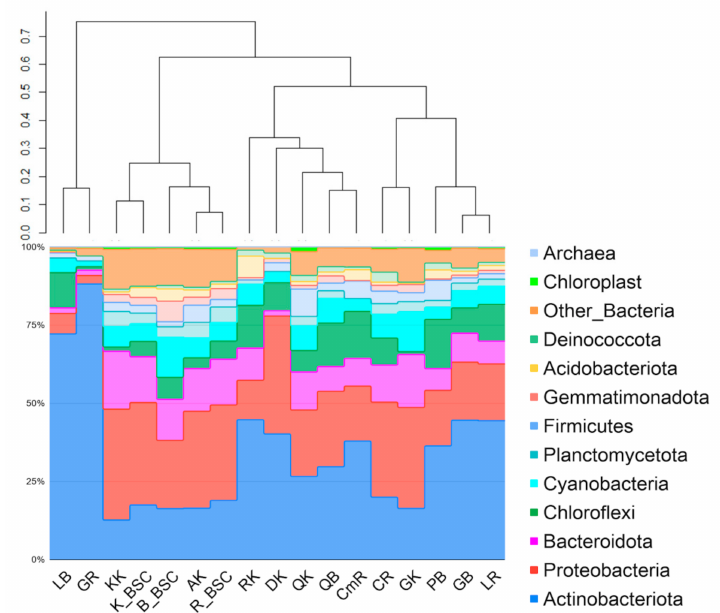
Figure 2. The structure of endolithic and biological soil crusts (BSCs) microbial communities based on the V3-V4 region of 16S rDNA. The sample groups’ IDs include the first letter of the rock type; the second letter was given according to the localization (GB—granite Bulunkul, PB—pegmatite Bulunkul, LB—limestone Bulunkul, QB—quartzite Bulunkul, LR—limestone Rangkul, GR—granite